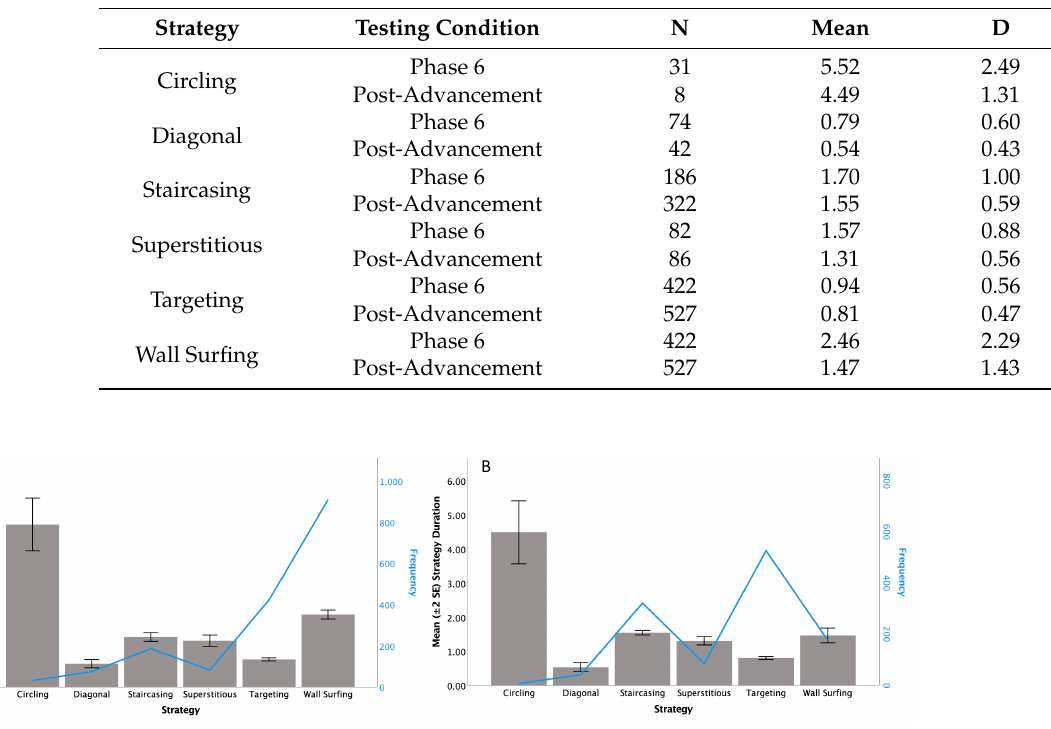
Table 2. Combined mean strategy duration of all sea lions by strategy in Phase 6 and Post-Advancement.